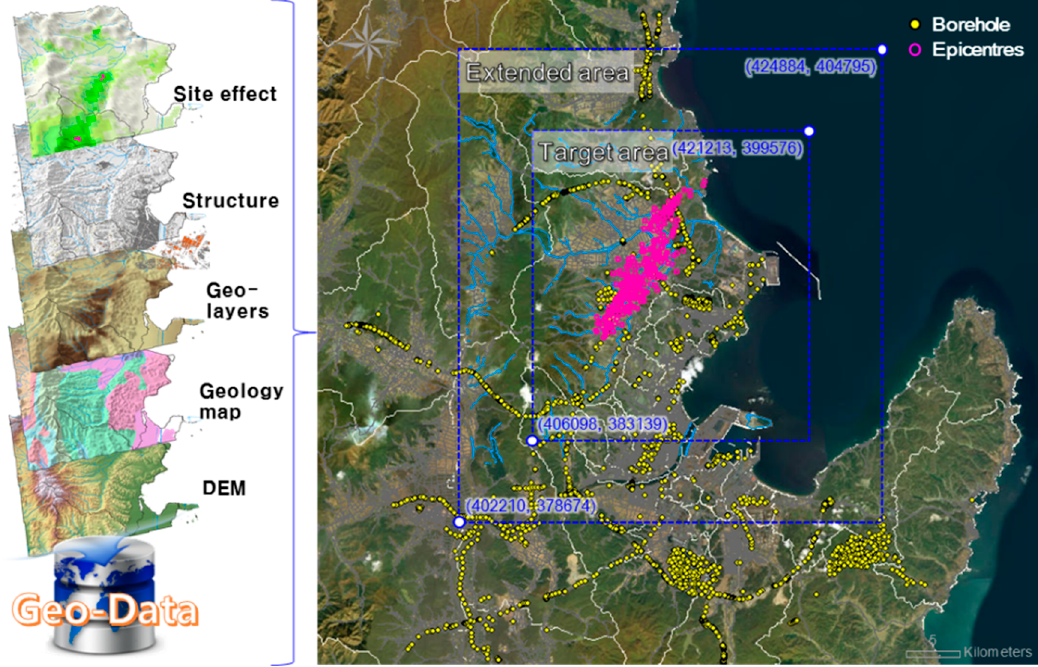
Figure 3. Extended and target areas for spatial modeling of geo-data in Pohang.